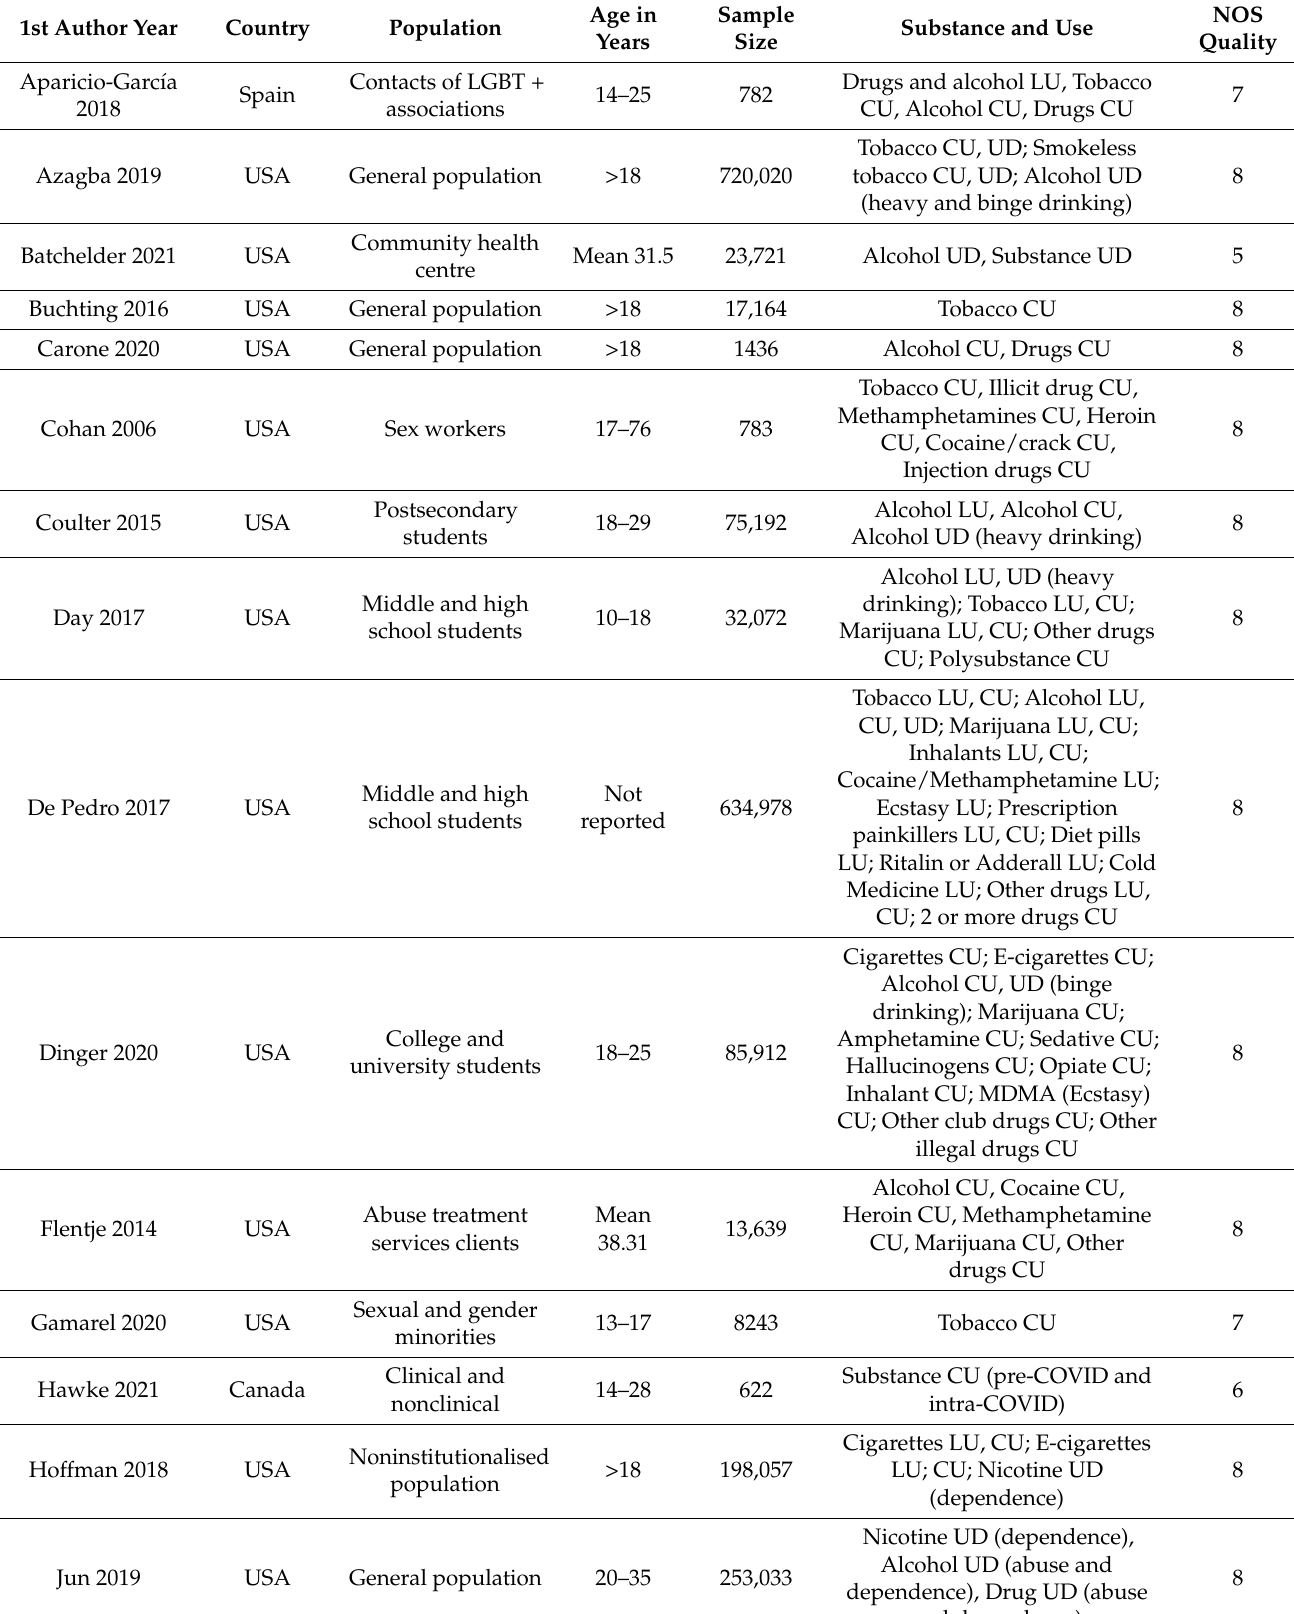
Table 1. Studies included in this review